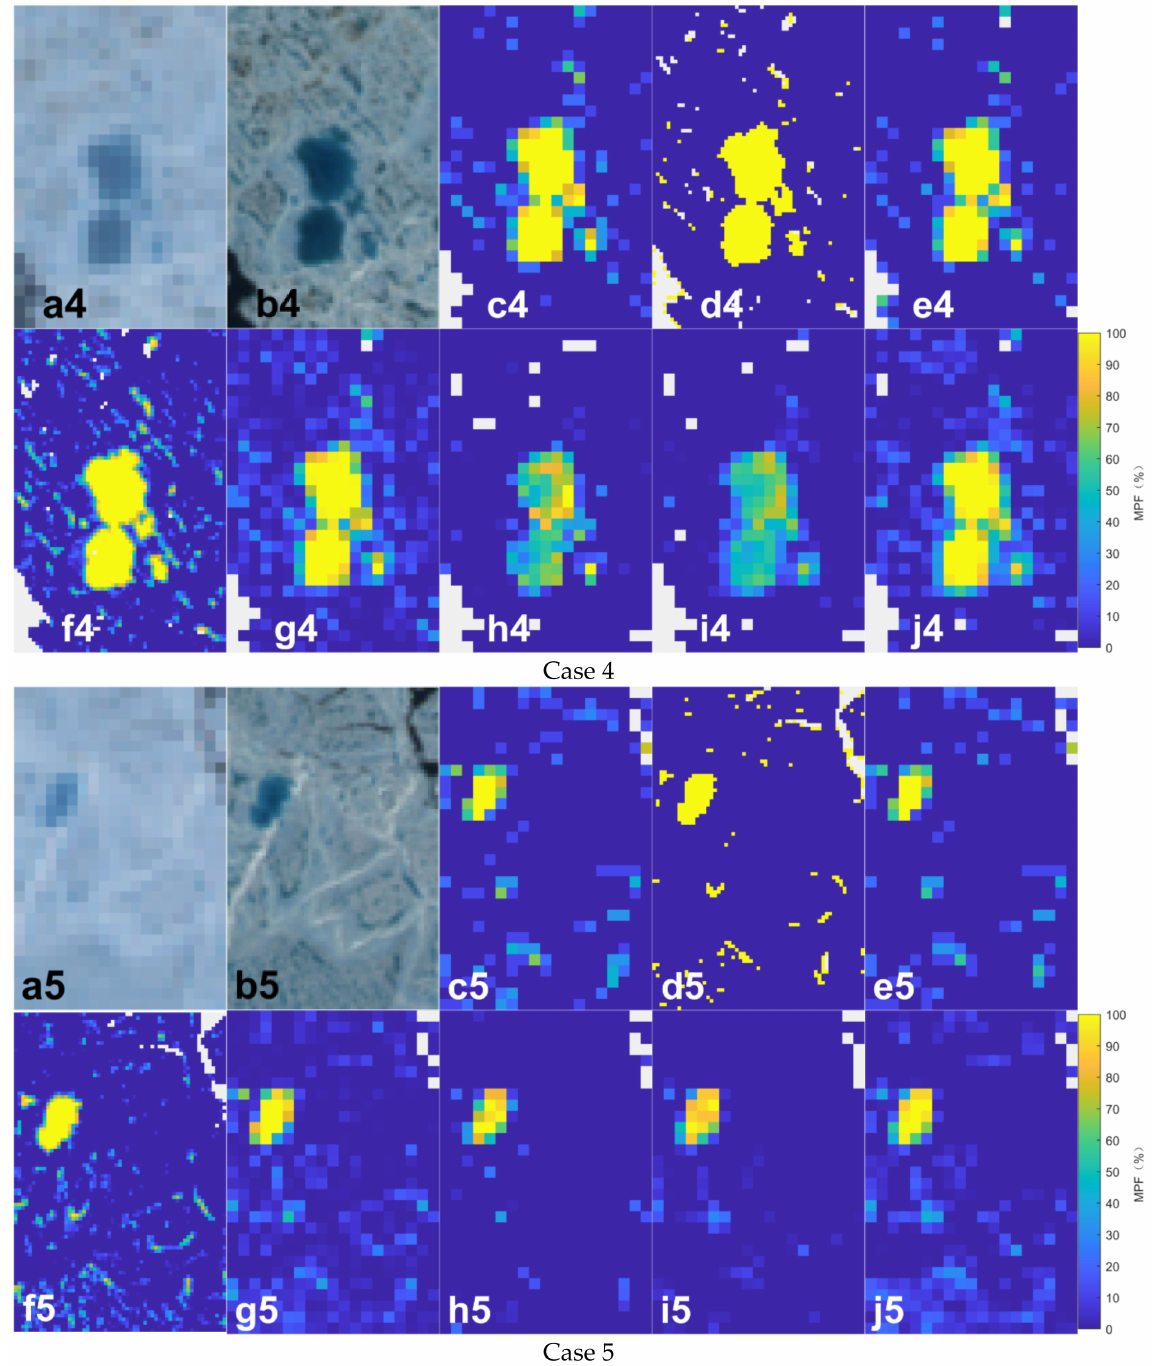
Figure 6. The retrieval results of the 5 cases. The numbers represent the order of the cases. The first line includes the true-color images and the S2 classification data of different algorithms; the second line includes the S2 retrieval data and the L8 retrieval results of different algorithms. The letters represent the true-color image of ( a ) L8 and ( b ) S2; ( c ) the SVM classification of S2 interpolated onto the L8 grid; ( d ) the ISODATA classification of S2; ( e ) the ISODATA classification of S2 interpolated onto the L8 grid; ( f ) the MPF of S2 using LinearPolar algorithm; ( g ) the result of ( f ) interpolated on the L8 grid; the MPF of L8 using ( h ) the Markus algorithm; ( i ) PCA; and ( j ) the LinearPolar algorithm. Among them, ( d ) uses the legend of d1; ( c ) and ( e )–( j ) use the color